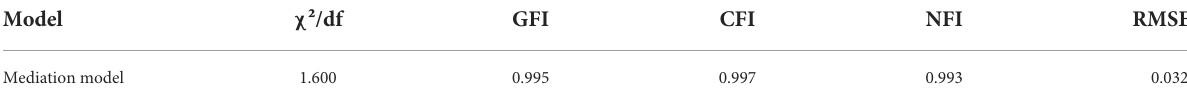
TABLE 14 Fitting index of the mediation model.